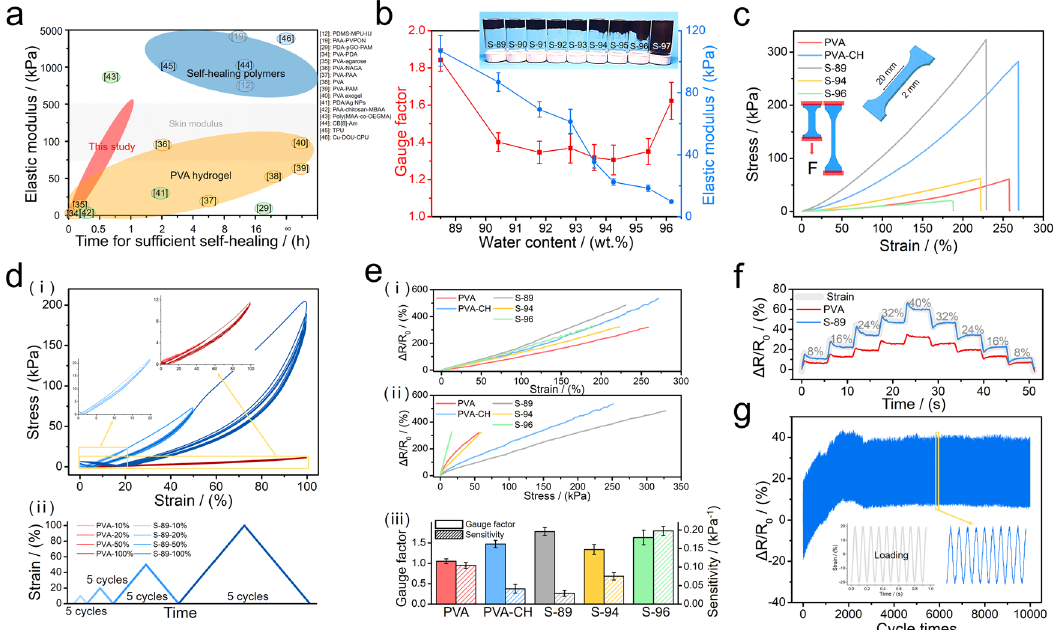
Fig. 3 Experimental evidence of mechanical tolerance and electromechanical properties of the PVA-S hydrogels. a Ashby plot of “ elastic modulus ” versus “ time for suf fi cient self-healing ” of PVA-S and other room-temperature self-healable polymers reported in the literature. b Summarized gauge factor and elastic modulus versus water concentration of PVA-S hydrogels. Insets show the PVA-S hydrogels with different water contents adhered at the bottom after fl ipping the vial for 10 min. c The tensile stress-strain curves of representative PVA-S hydrogels. d (i) Five successive cyclic tensile loading-unloading curves with different strains of PVA hydrogel and PVA-S hydrogel, respectively. The below fi gure (ii) shows the applied strain. e The electrical resistance variation versus (i) strain and (ii) stress for representative PVA-S hydrogels, respectively. The below fi gure (iii) calculated the gauge factor and sensitivity, respectively. f Resistance variation response curves of the PVA hydrogel and PVA-S hydrogel, respectively, under different static tensile states. g The durability test of a PVA-S hydrogel under a 20%